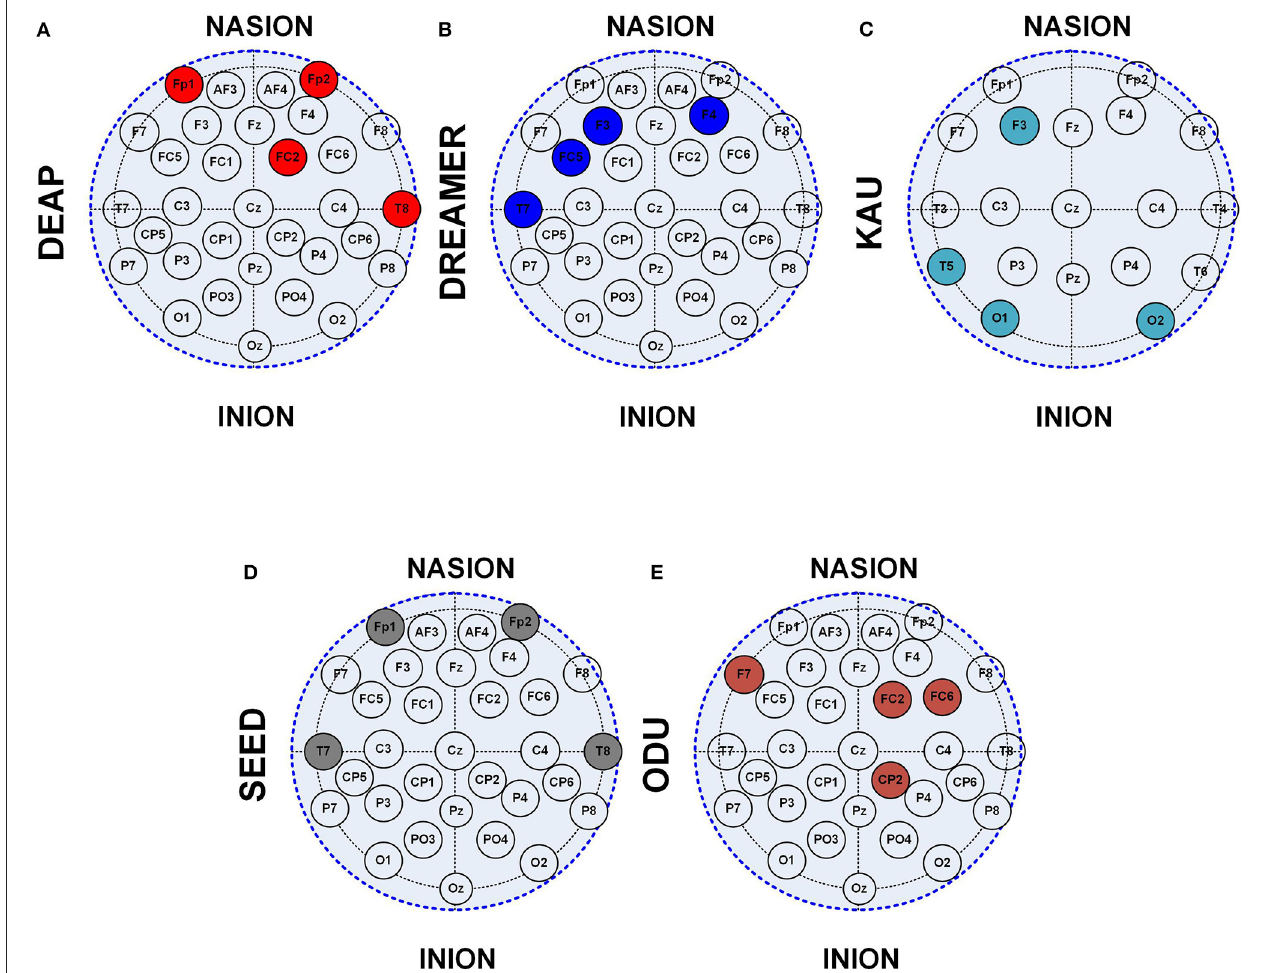
FIGURE 13 | Location of 4 channel EEG subset using 10–20 system on (A) DEAP, (B) SEED, (C) DREAMER, (D) ODU, (E) KAU data sets.